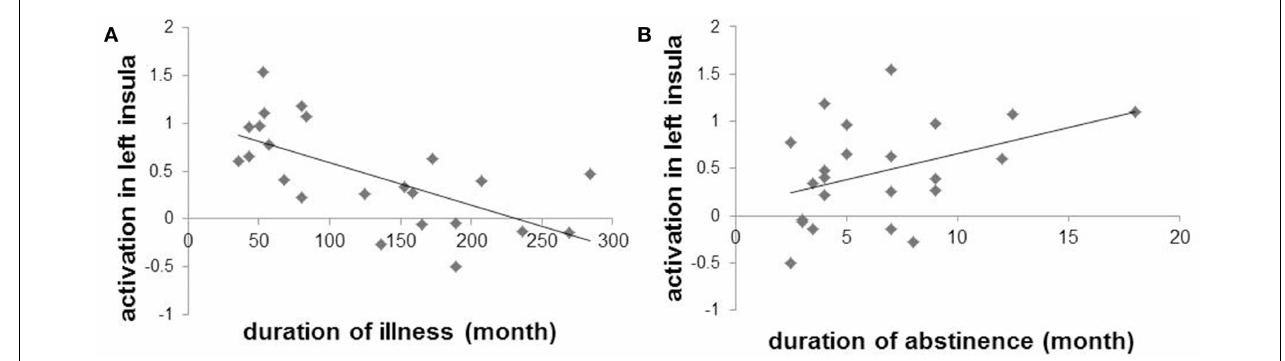
FIGURE 3 | Scatter plots and regression slopes of activation in left insula and duration of illness (A) or abstinence (B) in pathological gambling